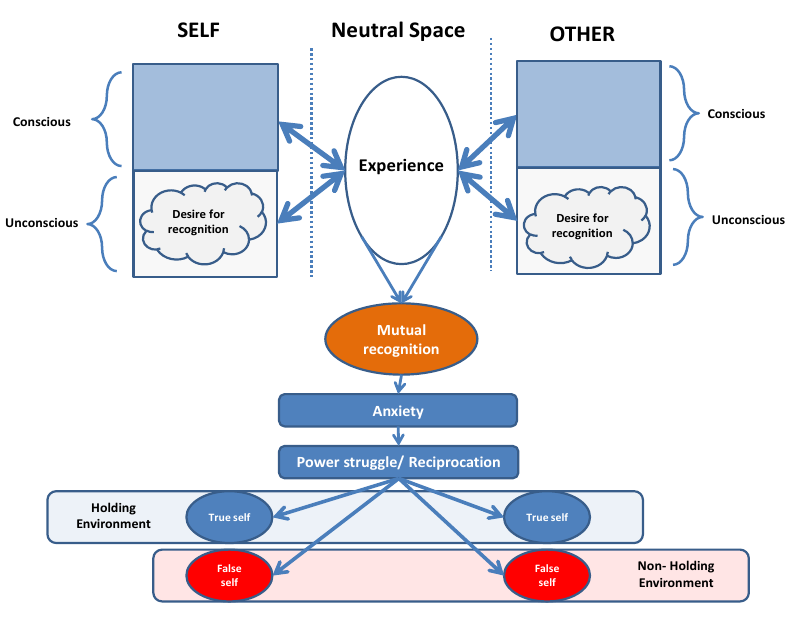
Figure 2. Winnicott’s Model.